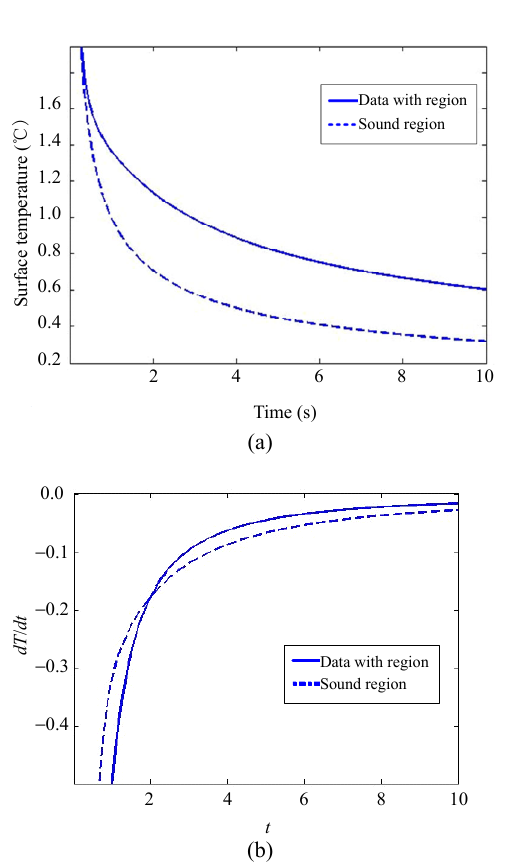
Fig. 9 Corresponding regional temperature of the defection area and its differential curve: (a) surface temperature curves and (b) first-order differential curve of the temperature on the